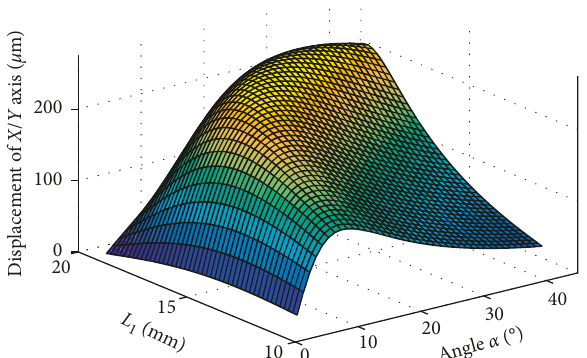
Figure 12: Maximum translational displacement plot in terms of L 1 and α